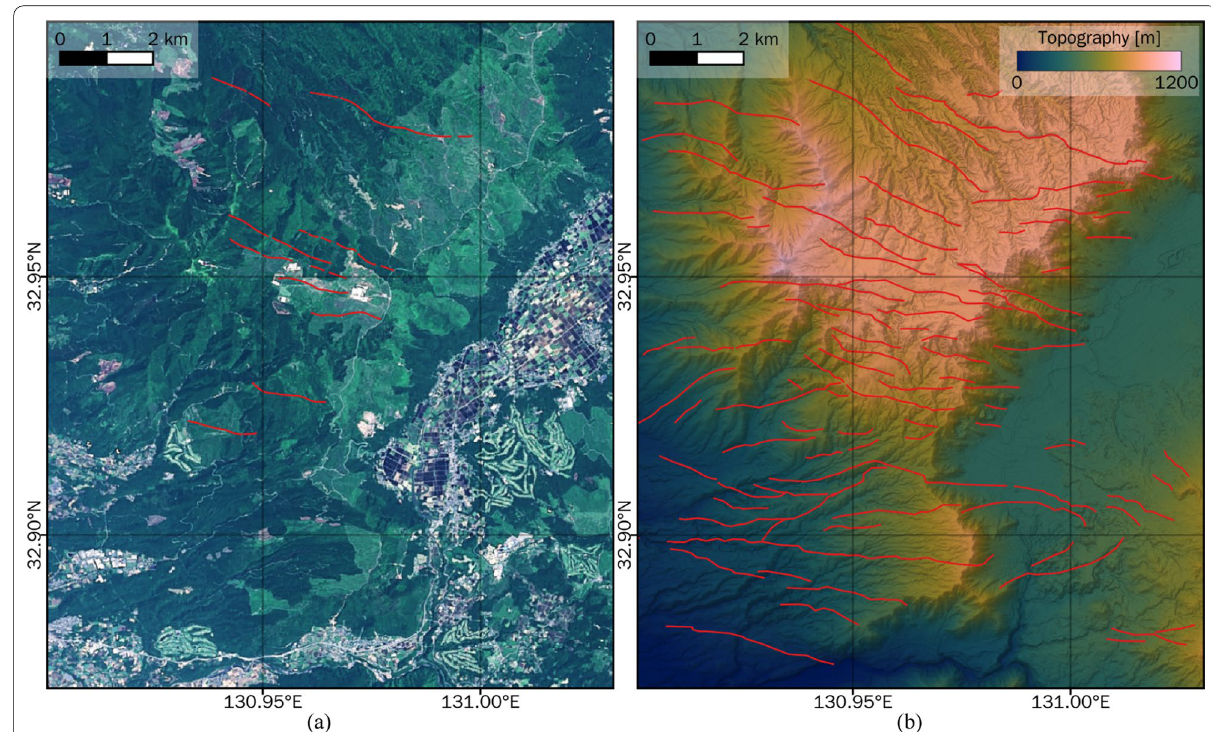
Fig. 1 a Optical image in the northwest of the outer rim of the Aso caldera. The red lines denote known active faults (Nakata and Imaizumi 2002). b Topography. The red lines denote the displacement lineaments identified by Fujiwara et al. (2016, 2020)